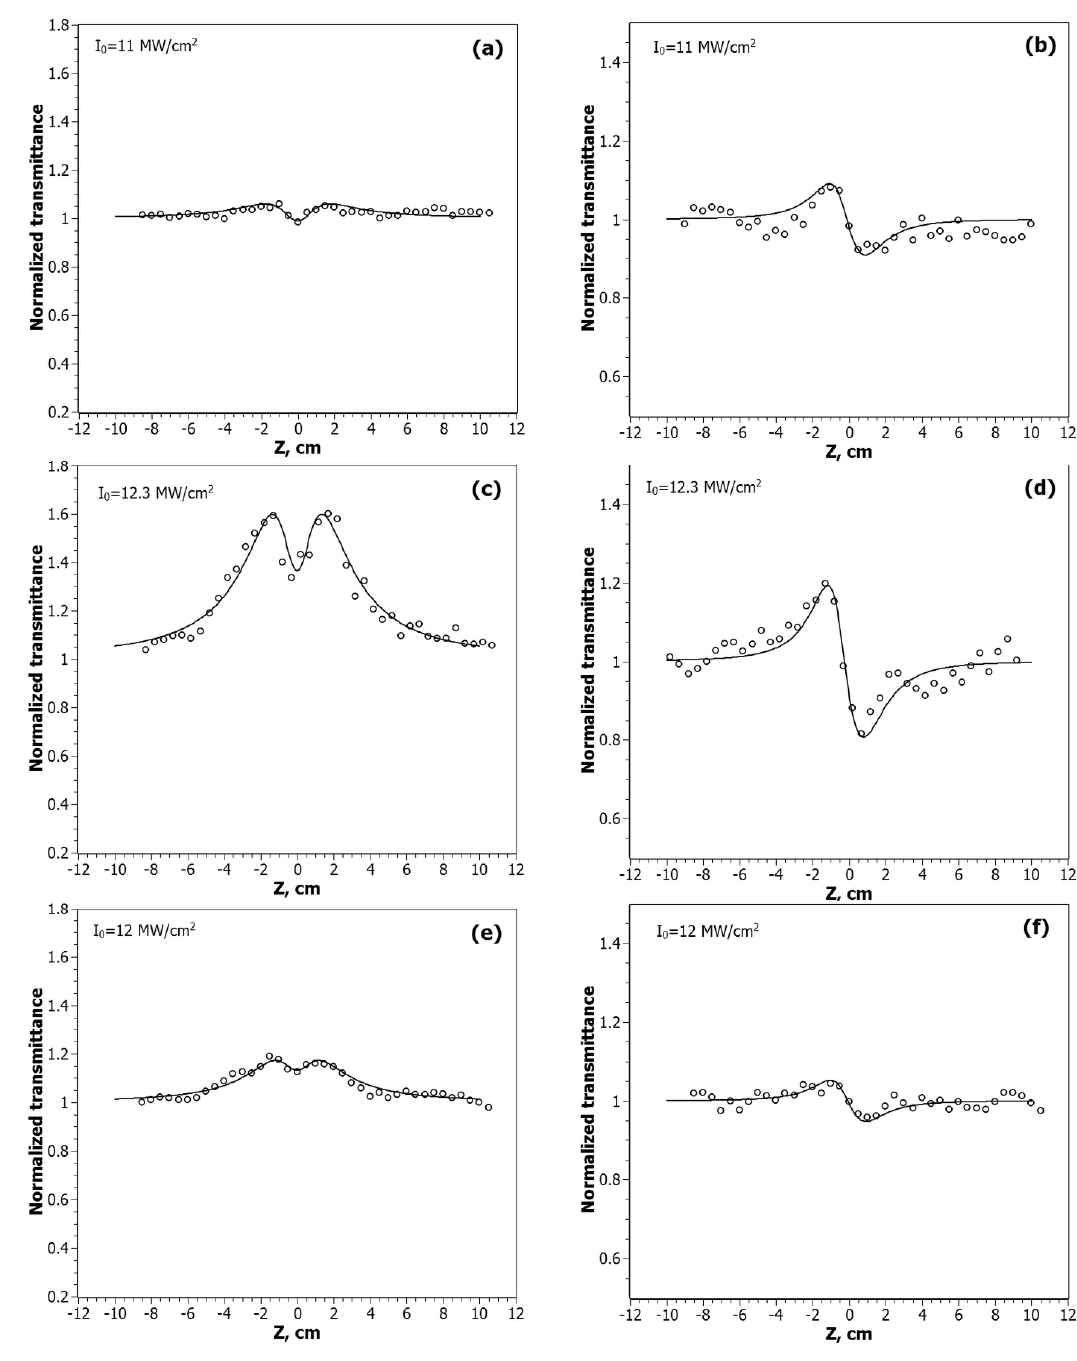
Figure 5. Z-scan profiles of the normalized transmittance measured for CdC8+Ag/Au NPs at the wavelength λ = 532 nm in the open-aperture (OA) scheme: CdC8+Ag/Au (1:1)—( a ), CdC8+Ag/Au (3:1)—( c ), CdC8+Au/Ag (3:1)—( e ); and the closed-aperture (CA) scheme: CdC8+Ag/Au (1:1)—( b ), CdC8+Ag/Au (3:1)—( d ), CdC8+Au/Ag (3:1)—( f ). Solid lines are theoretical fits of the experimental data.